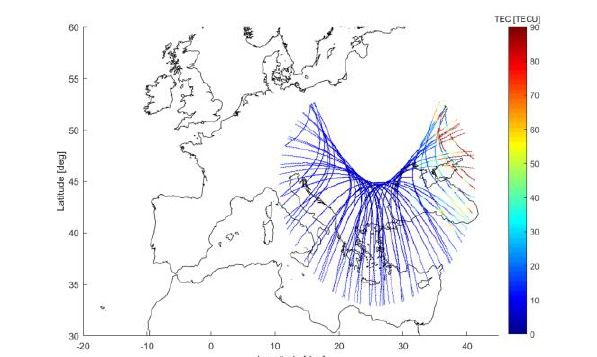
Figure 14. Ionospheric pierce points with line of sight RMS value calculated from the EGNOS VTEC map. The simulated site is in Bucharest on 20/08/2018